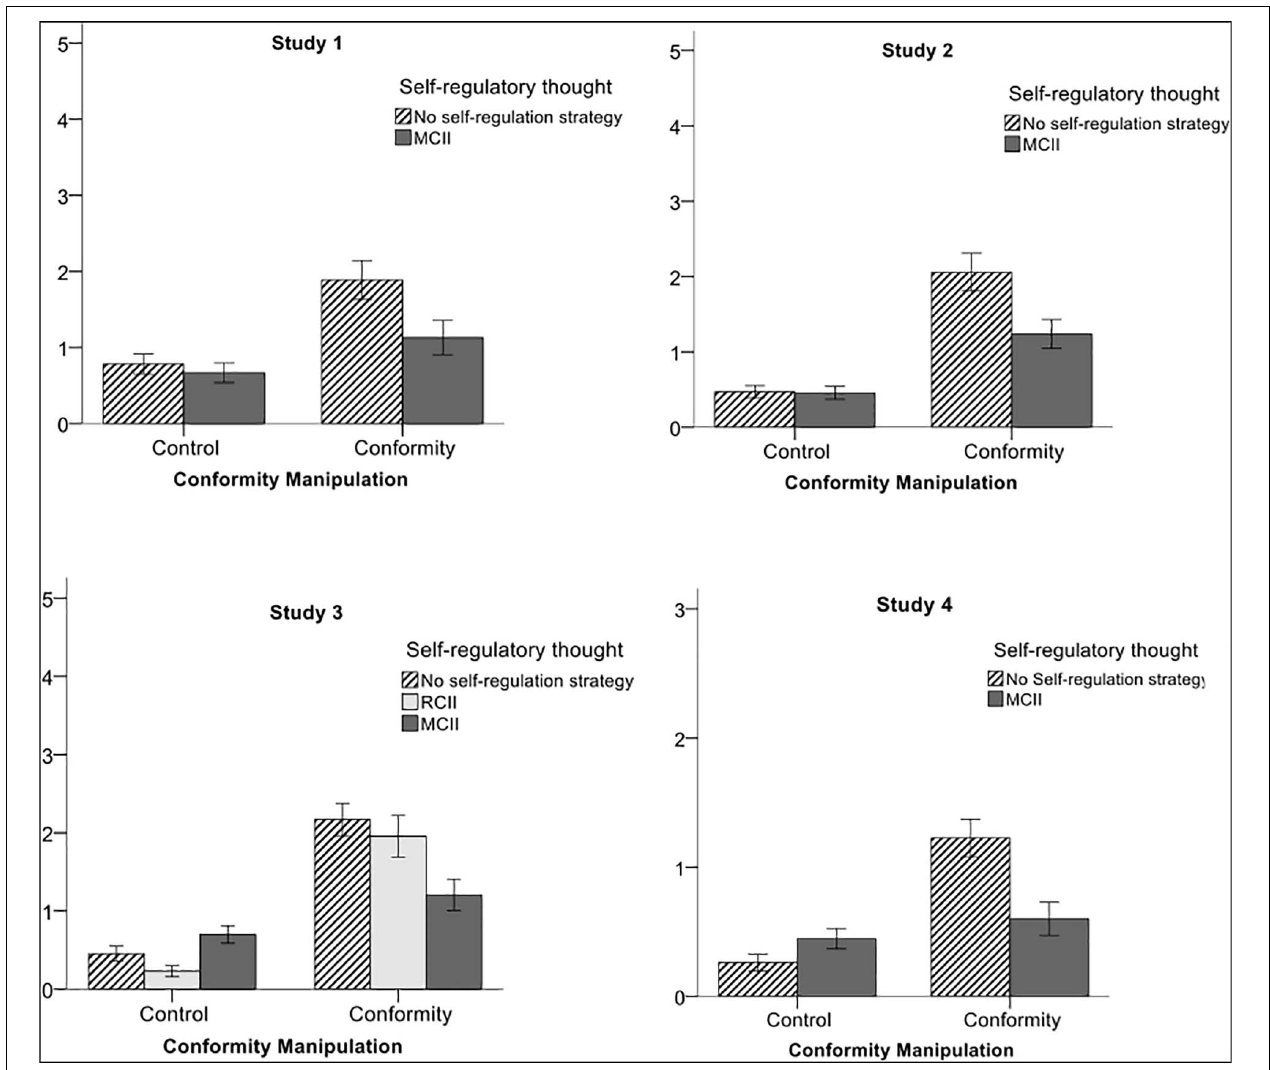
FIGURE 3 | Mean number of conform answers (dependent variable) for all conditions. Standard errors are represented by the error bars attached to each column.